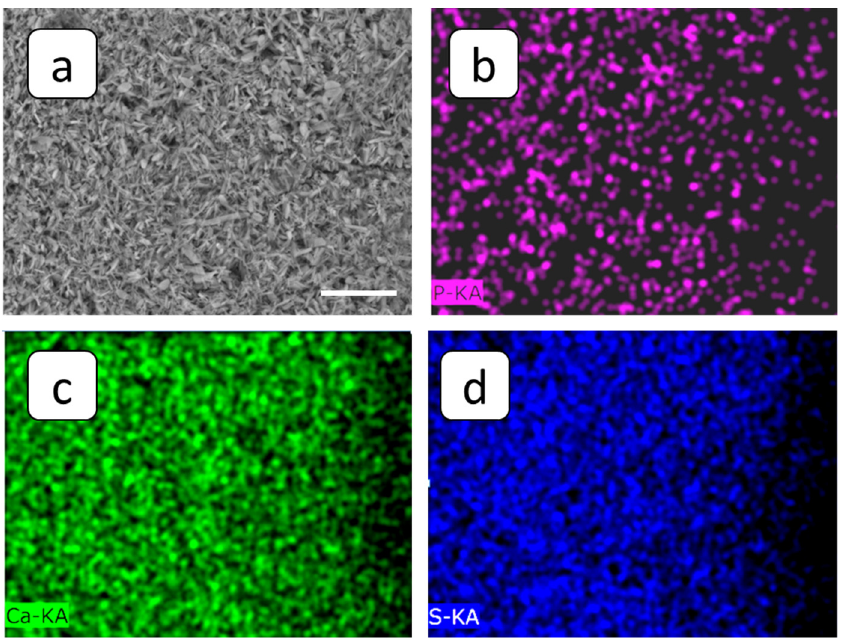
Figure 11. Images of the cation-exchange membrane MK-40 after the experiment run in the presence of HEDP-F: SEM image ( a ) and SEM-EDS maps of phosphorus ( b ) calcium ( c ) and sulfur ( d ). Scale bar: 60 µm.